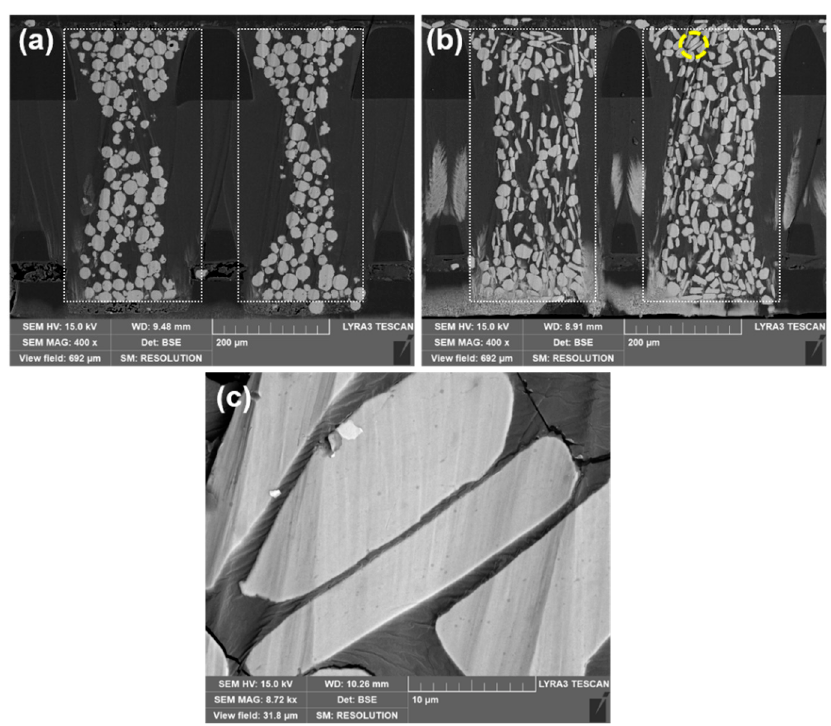
Figure 6. The cross-sectional scanning electron microscopy images of the fabricated pressure conductive silicone rubber socket device with ( a ) spherical Ni powder, ( b ) flake-type Ni powder: dotted lines are for defining the channel area, and ( c ) high-magnification image of flake-type Ni powder (encircled area).